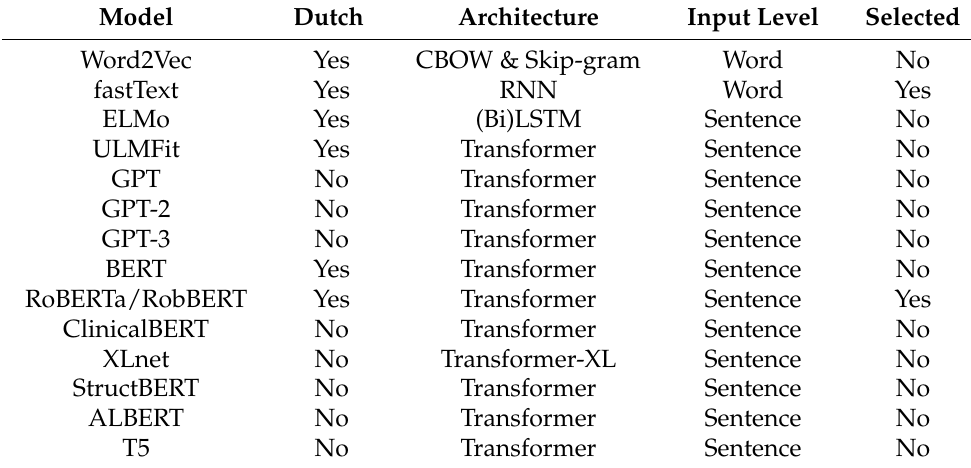
Table 2. Overview of neural network models under consideration for identifying language markers in